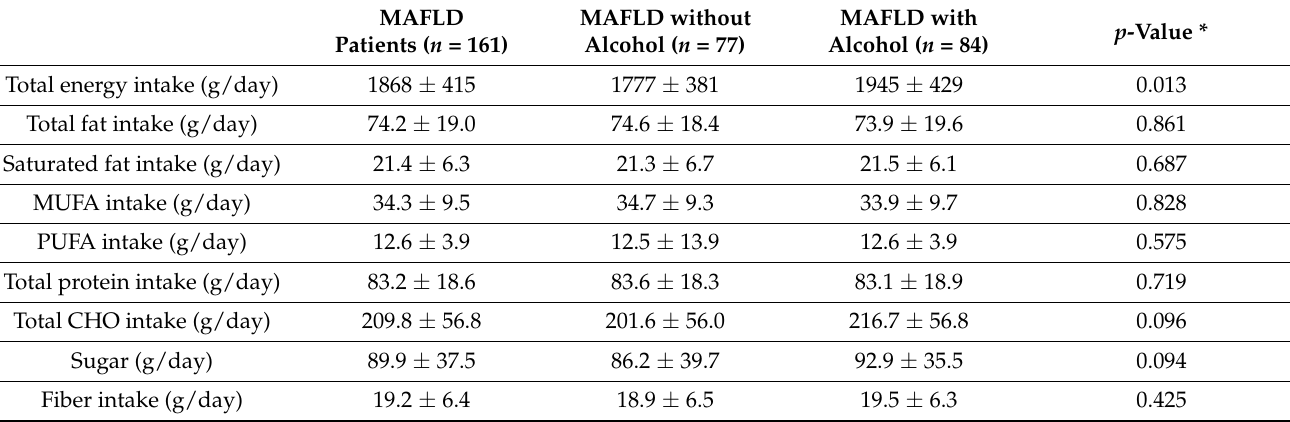
Table 2. Dietary intake in MAFLD